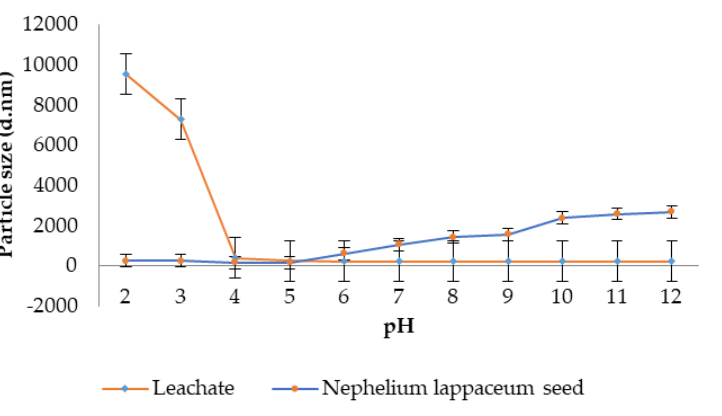
Figure 6. pH effect on particle size of leachate.